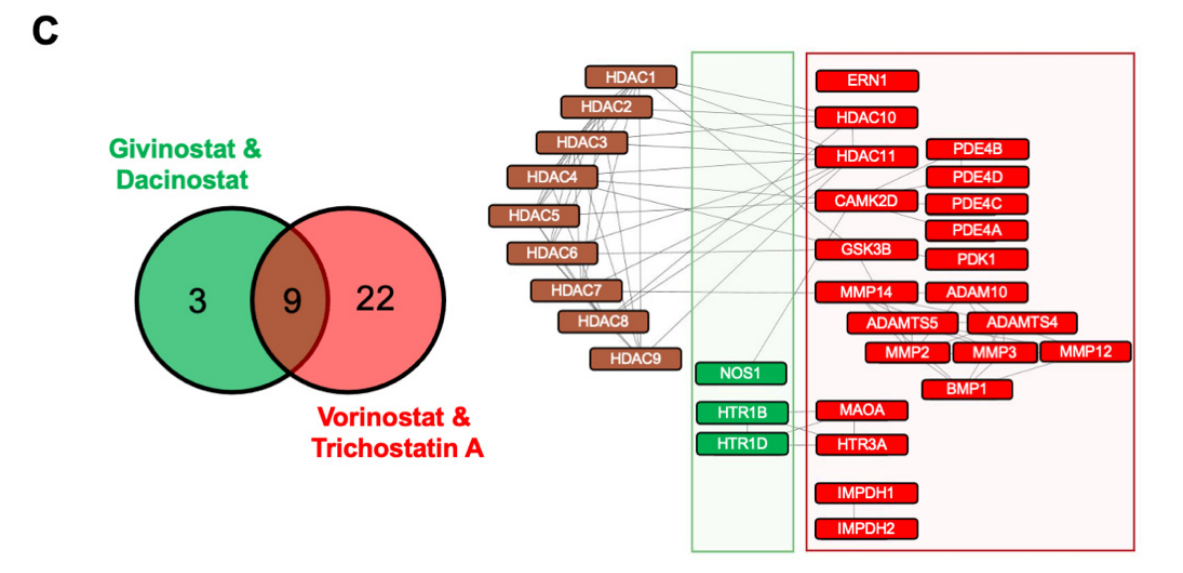
Figure 4. The effects of combinatory pan-HDAC inhibitors and activated CTL in parental and CTL- resistant SW1990 and BxPC3. ( A ) All PDAC cells were pre-treated with HDACi at 10 µM for 24 h, following co-treatment with varying concentrations of CTLs. Points represent mean ± S.D. of at least three replicates. ( B ) Chemical structures of HDACi were imported into SwissTargetPrediction, and a heat map was generated. ( C ) Venn diagram shows the number of common targets in the most potent HDACi (givinostat and dacinostat, green cluster) and the less potent HDACi (vorinostat and trichostatin A, red cluster). Protein–protein interaction network was constructed using STRING.